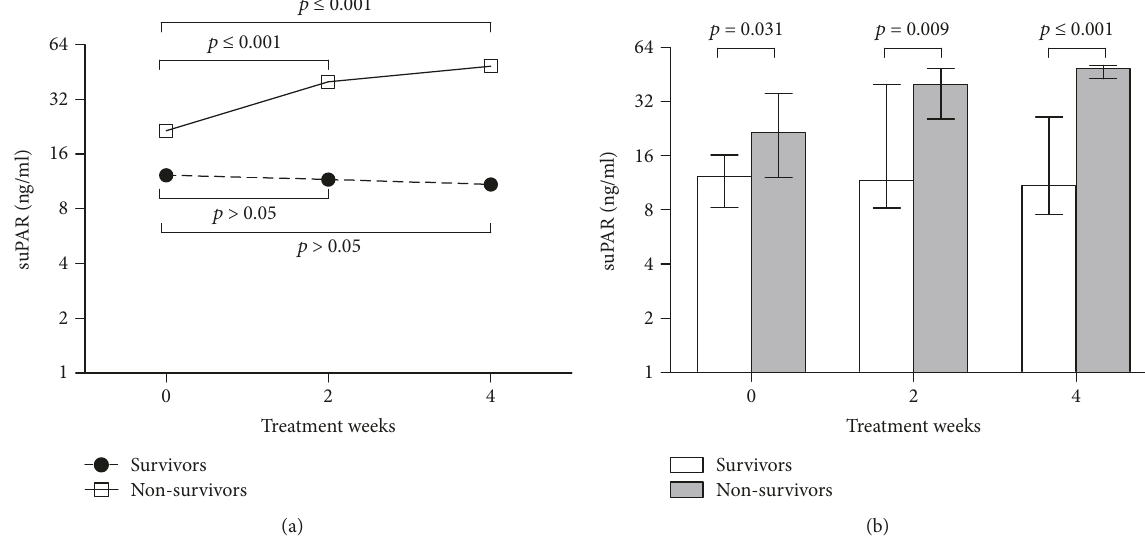
Figure 3: Longitudinal analysis of serum suPAR level between survivors and nonsurvivors in HB-ACLF patients during a 4-week therapy. (a) Temporal dynamics of serum suPAR level in HB-ACLF patients between the survivors and nonsurvivors group. (b) Comparison of suPAR level at individual time between the survivors and nonsurvivors